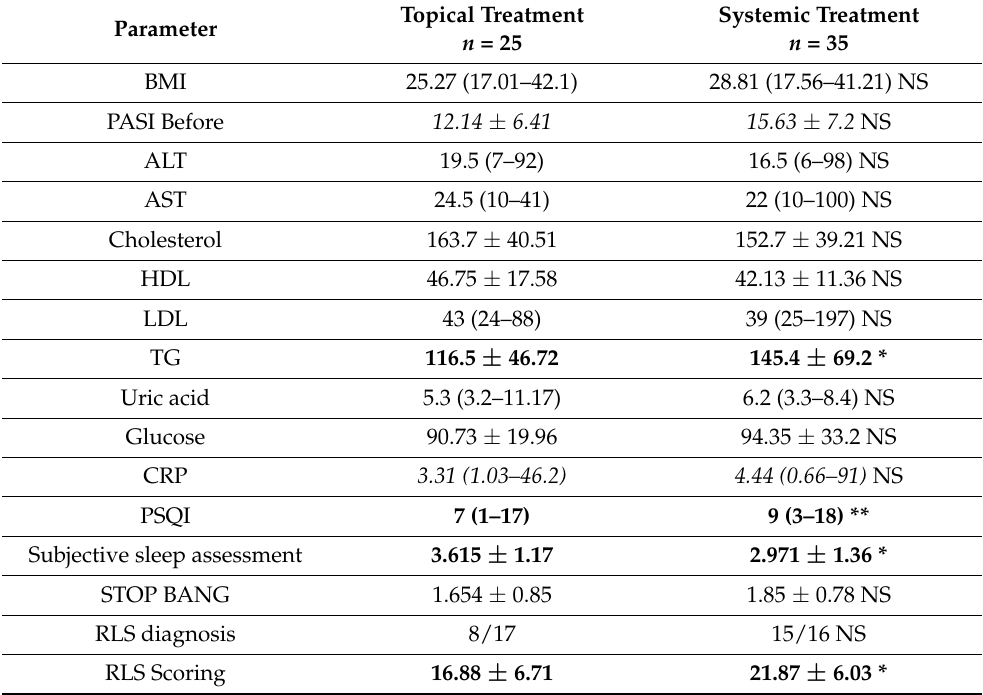
Table 4. Comparison of baseline data, laboratory parameters, and values assessing the quality of sleep between topical and systemic treatment